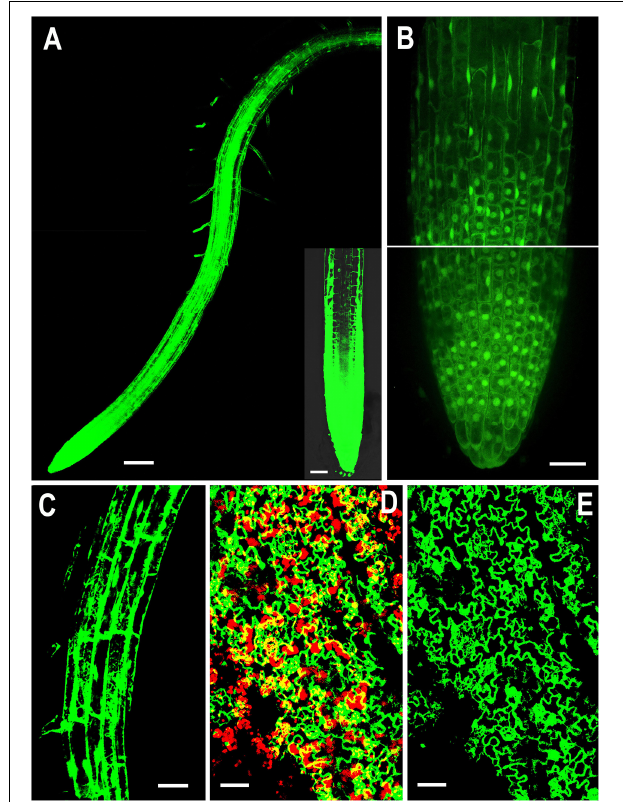
FIGURE 1 | Representative confocal images showing localization of overexpressed NMig1 gene in the root and leaf tissues of 6-day-old Arabidopsis thaliana . Expression pattern of 35S:NMig1-GFP in: (A) primary root, (B) primary root meristem, (C) cells from root elongation zone, (D) and (E) leaf epidermal cells and chlorophyll autofluorescence (red). Scale bars: (A) 100 µ m; (B) , (D) and (E) 20 µ m; (C) 50 µ